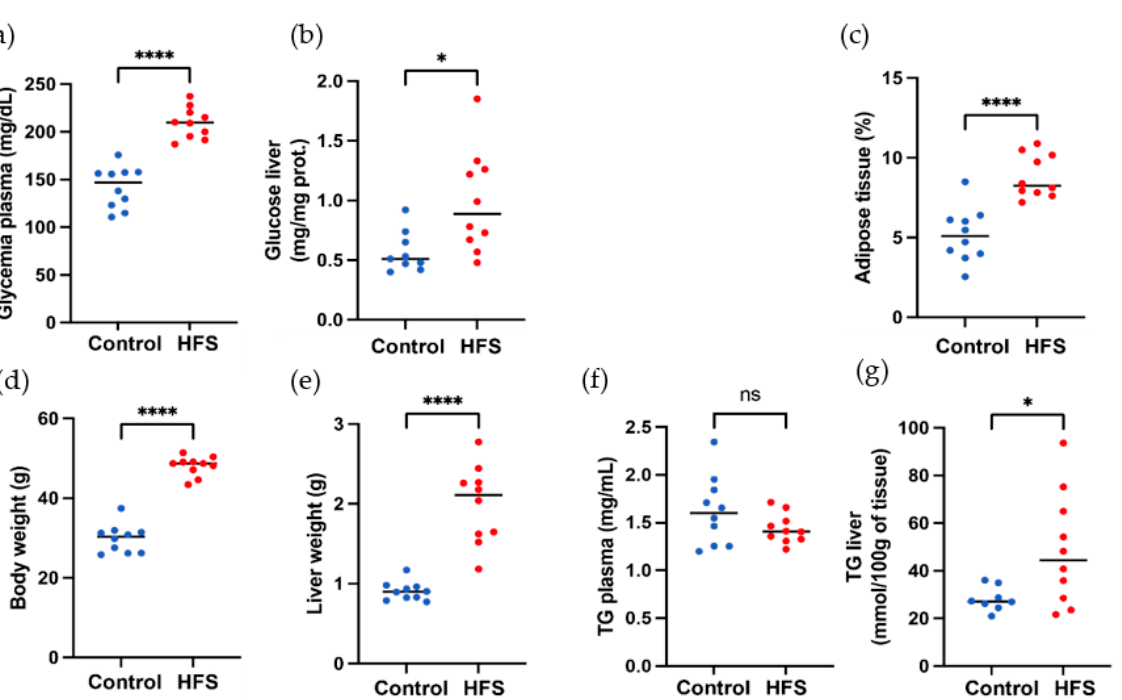
Figure 5. Morphological and biochemical parameters of mice. ( a ) Body weight, ( b ) liver weight, ( c ) adiposity, ( d ) glycemia plasma level in liver, ( e ) glucose level in liver, ( f ) TG plasma liver, and ( g ) TG liver. Red color corresponds to HFS diet mice, and blue color to control mice, ns: p -value > 0.05; *: p -value ≤ 0.05; ****: p -value ≤ 0.0001.